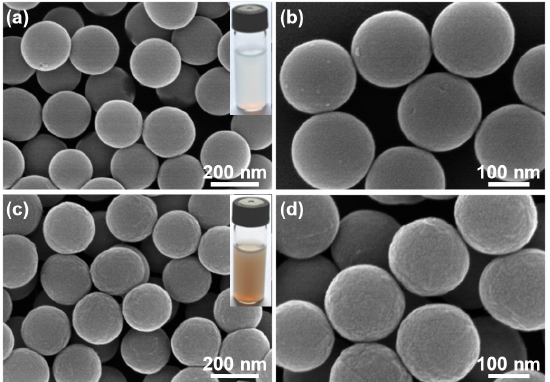
Figure 2. ( a , b ) FE-SEM images of pure SiO 2 microspheres at low and high magnifications, respectively, showing smooth external surface; the inset in ( a ) is a digital photograph of their aqueous suspension, which is pure white in color; ( c , d ) FE-SEM images of SiO 2 /GO microspheres at low and high magnifications, respectively, showing relatively rougher outer surface; the inset in ( c ) is a digital photograph of their aqueous suspension, which is yellow-brown in color.